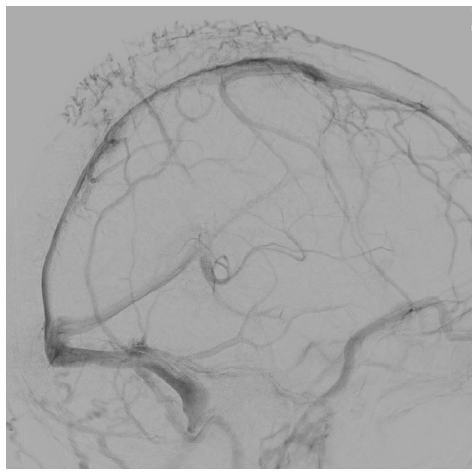
Figure 6. DSA reveal no flow into the internal jugular vein and many collaterals through the sagittal sinus.